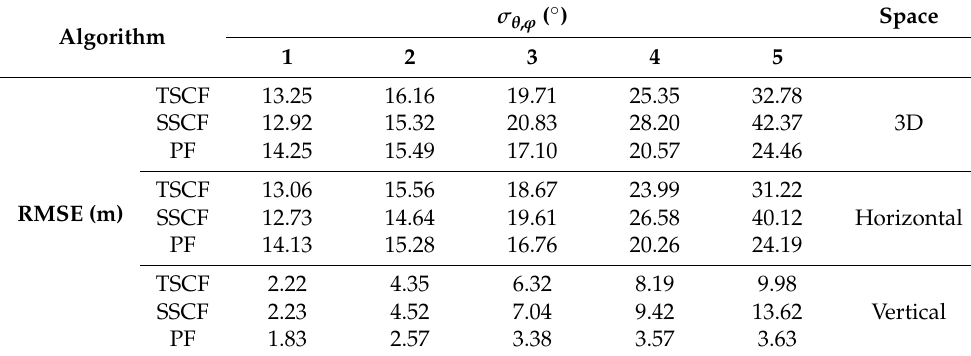
Table 1. RMSE results of the batch-processing solutions with certain UAS positions and using 101 measurement points.